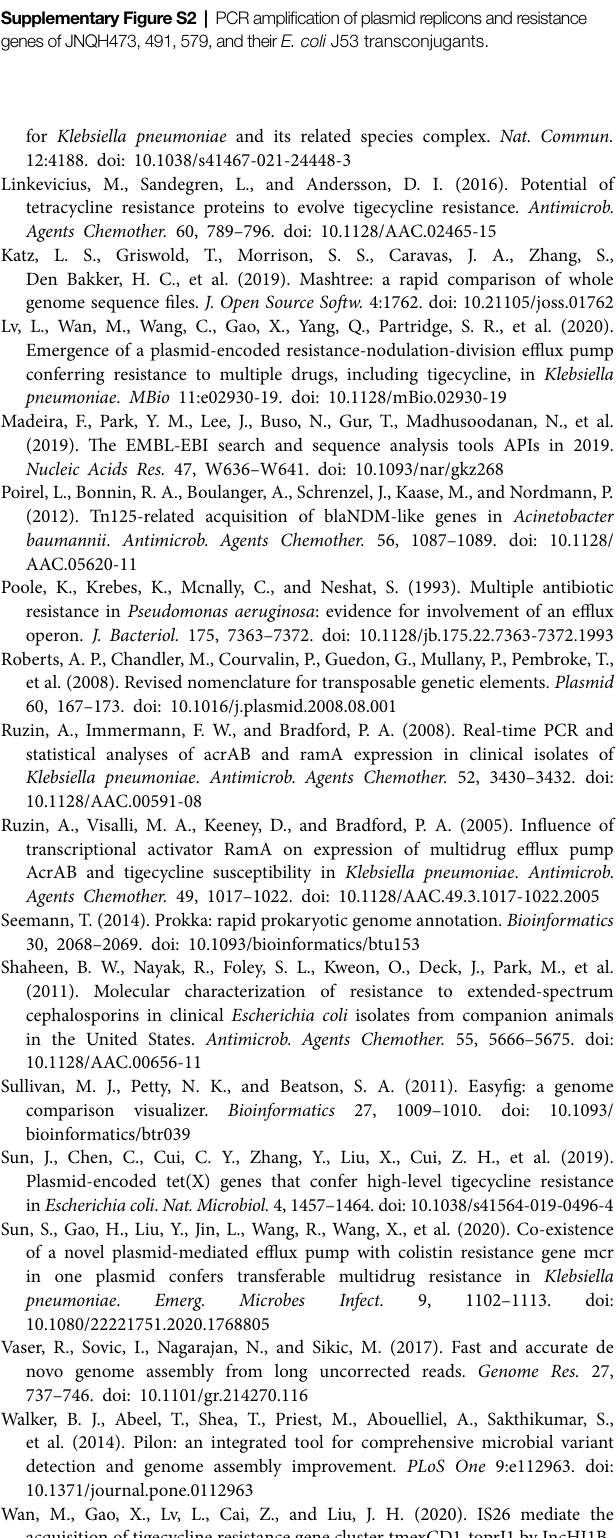
Supplementary Figure S1 | Multiple sequence alignment of amino acids of TmexCD1-ToprJ1 , TmexCD2-ToprJ2 , and TmexCD3-ToprJ3 . Conserved residues were displayed in dark blue background and mutants were highlighted in white background. Supplementary Figure S2 | PCR amplification of plasmid replicons and resistance genes of JNQH473, 491, 579, and their E. coli J53